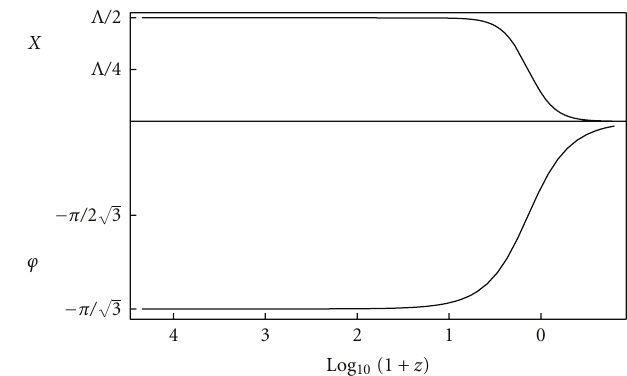
Figure 2: Evolution of the scalar field density parameter versus redshift (see [33]). The continuous line shows the UDM density parameter; the dashed line is the density parameter of the DM + DE components in a standard Λ CDM model; the dotted line is the radiation density parameter.